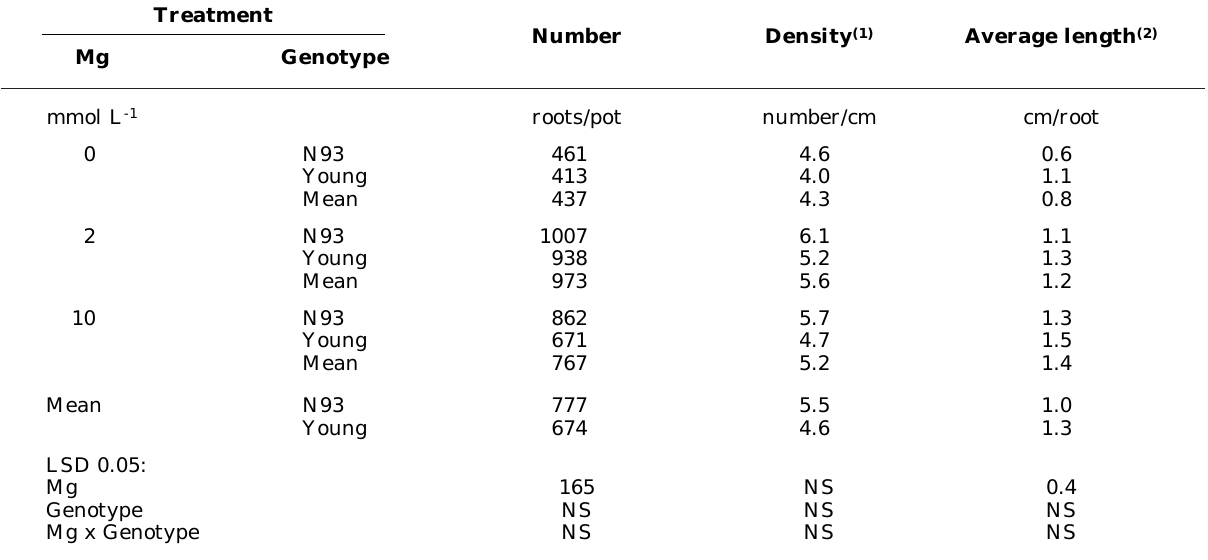
Table 2. Characteristics of lateral roots at harvest in the subsurface solution compartment of Experiment 1 for soybean line N93-S-179 (N93) and cv. Young as a function of Mg concentrations in solution maintained at pH 4.6 without